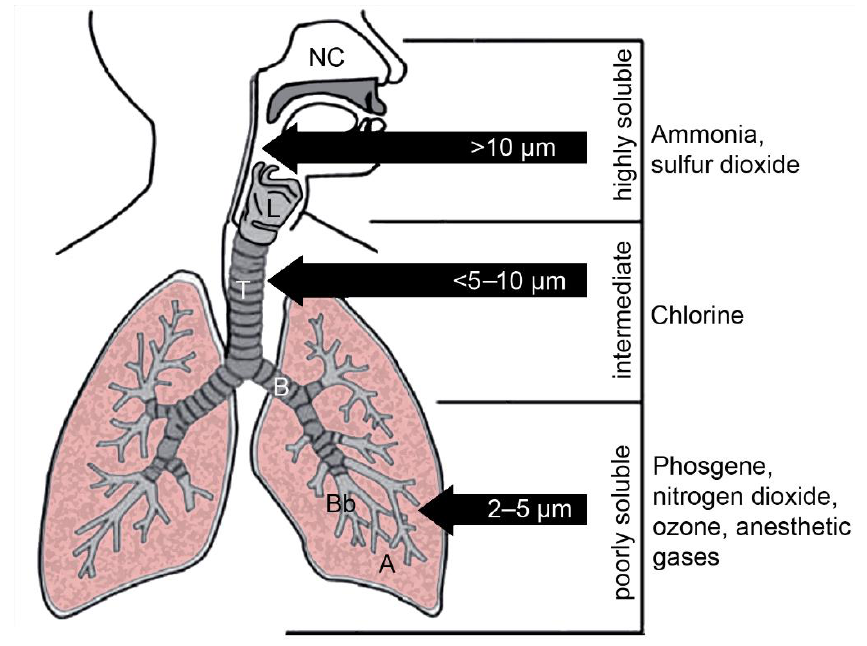
Figure 1. Upper respiratory tract with nose, nasal cavity (NC), mouth, pharynx and larynx (L), and lower respiratory tract with the (air) conducting parts trachea (T), bronchi (B) and bronchioles (Bb), and the respiratory part with respiratory bronchiole and alveoli (A), are shown. Contact of inhaled particles with the respiratory tract is mainly determined by size. Solubility in water regulates the action of gases in the airways. Examples for important gases with high, intermediate and poor water solubility are